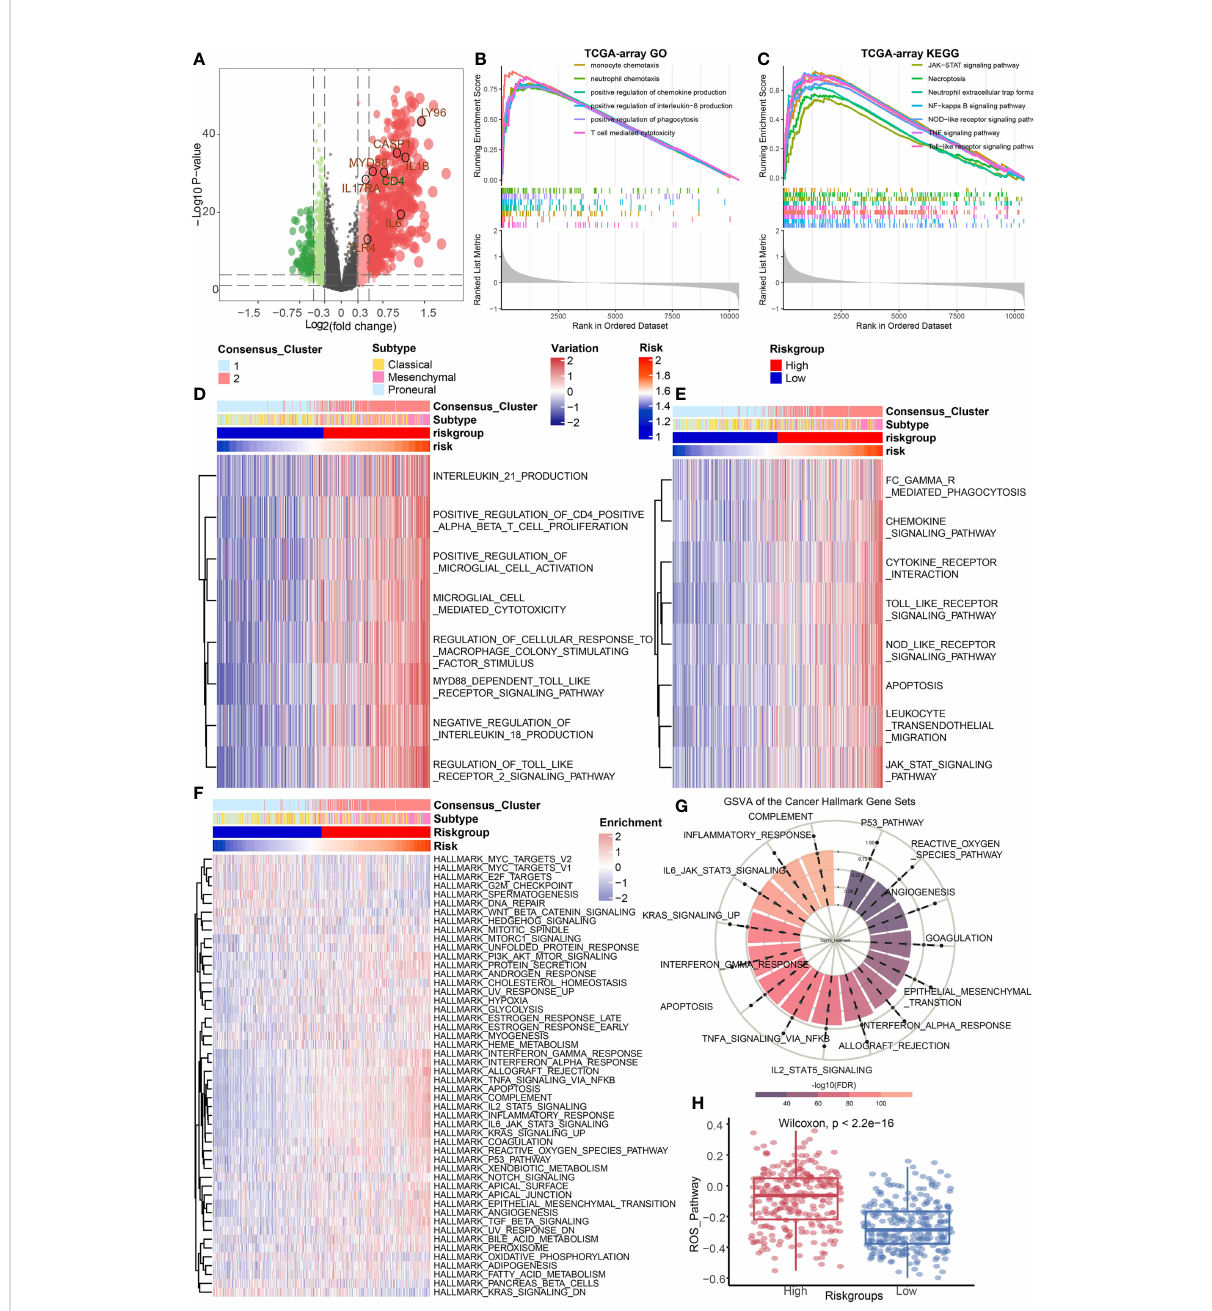
FIGURE 3 Identi fi cation of DEGs and functional enrichment analysis. (A) The differentially expressed genes between high and low risk group were identi fi ed based on the TCGA Array dataset. (B, C) GSEA results of GO terms (B) and KEGG pathways (C) based on the differentially expressed gene sets in the TCGA Array dataset. (D, E) GSVA results of GO terms (D) and KEGG pathways (E) based on the differentially expressed gene sets in the TCGA Array dataset. (F, G) ssGSEA results of the 50 “ hallmark ” gene sets from the Molecular Signature Database. (H) ssGSEA results suggested the ROS pathway was enriched in the high-risk group. P < 0.05, statistically signi fi